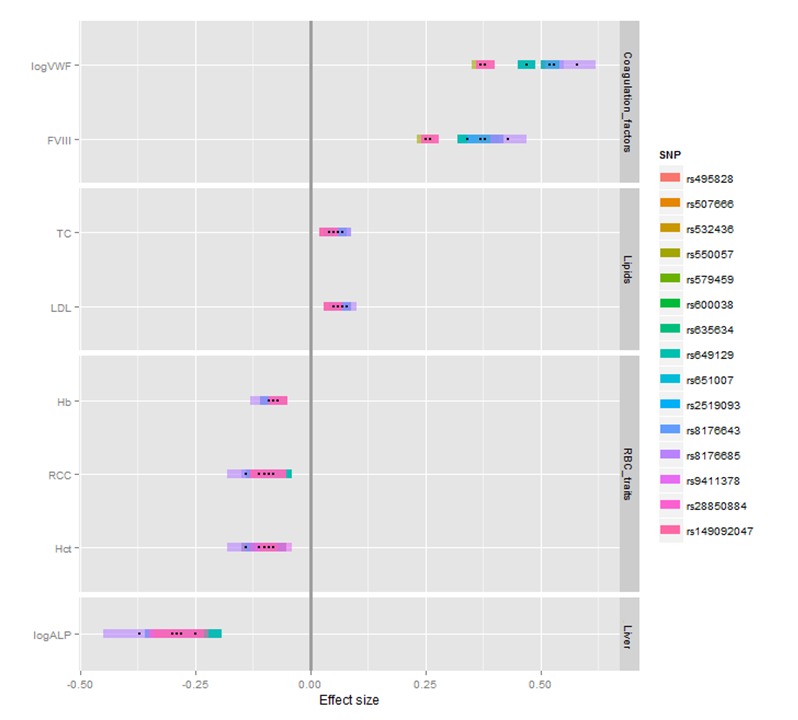
Comparison of the effect sizes on 15 ABO SNPs between eight different traits.Traits include von Willebrand factor (log transformed, logVWF) and factor VIII (FVIII) for coagulation factors, total cholesterol (TC) and low-density lipoprotein (LDL) for lipids, hemoglobin (Hb), red blood cell count (RCC) and hematocrit (Hct) for the red blood cell (RBC) traits and alkaline phosphatase (log transformed, logALP) for liver marker group. The colored bar for each SNP represents the 95% confidence interval of the effect size.